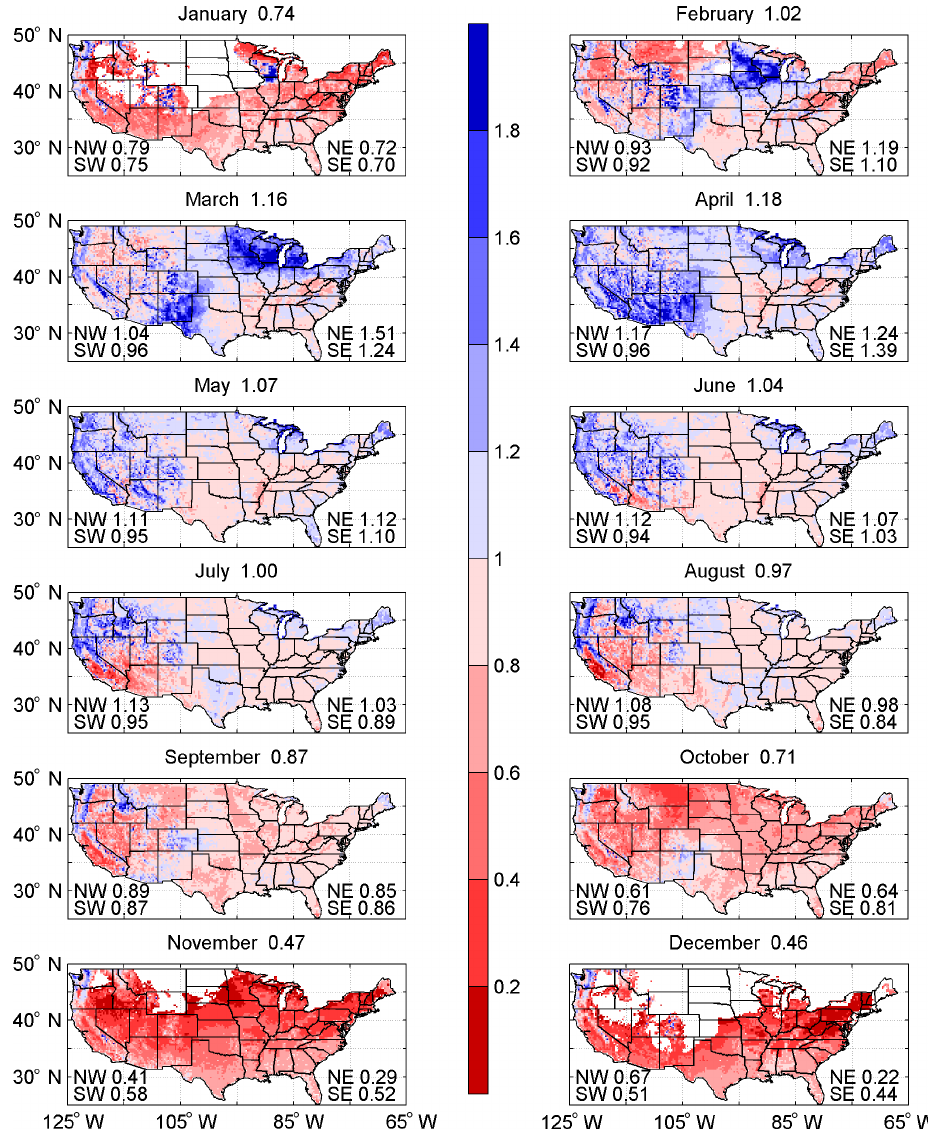
Figure 2. Scaling factor as the ratio of the CLM simulated ET to the GLEAM ET for each month during 1986–1995. The numbers in titles are CONUS-averaged values, and the numbers within figures are area-averaged values for each of the four sub-regions (NW, SW, NE, and SE). The areas with negative scaling factors are masked